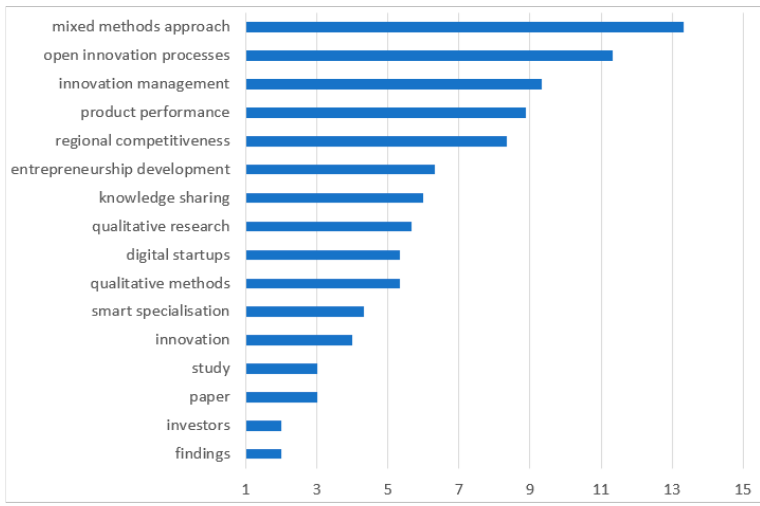
Figure 3. Identification of keywords by the Rapid Automatic Keyword Extraction method (RAKE) (source: own study).